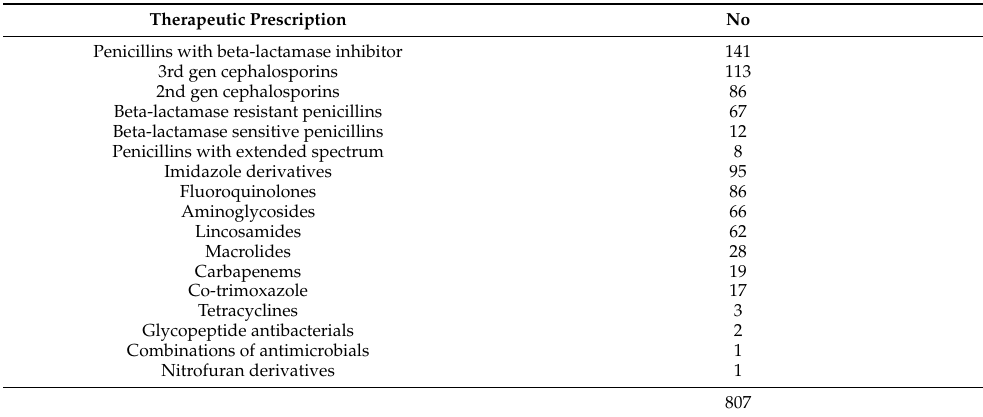
Table 6. Antibacterials for Systemic Use (Therapeutic and Prophylactic).